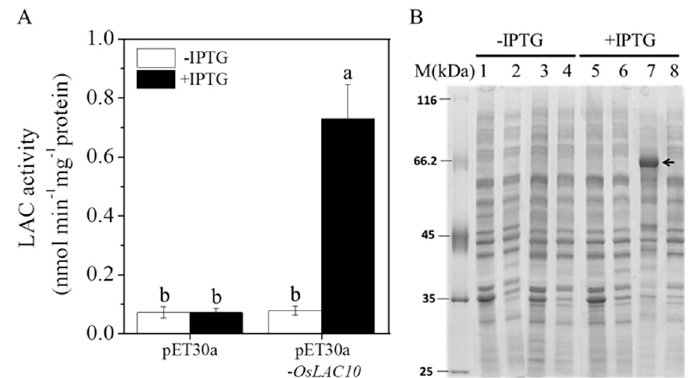
Figure 6. Expression of the OsLAC10 protein in E . coli . ( A ) Intracellular laccase activity of the E . coli BL21(DE3) strain expressing OsLAC10; ( B ) SDS-PAGE of the pET30a- OsLAC10 recombinant protein; lanes 1 and 2, pET30a precipitate and supernatant; lanes 3 and 4, pET30a- OsLAC10 precipitate and supernatant; lanes 5 and 6, pET30a precipitate and supernatant with 1 mM IPTG; lanes 7 and 8, pET30a- OsLAC10 precipitate and supernatant with 1 mM IPTG. M, protein marker. Black arrows represent target proteins. The data are the means ± SD ( n = 3). Different letters (a, b) above the column indicate a significant difference at p < 0.05 according to the LSD tests.